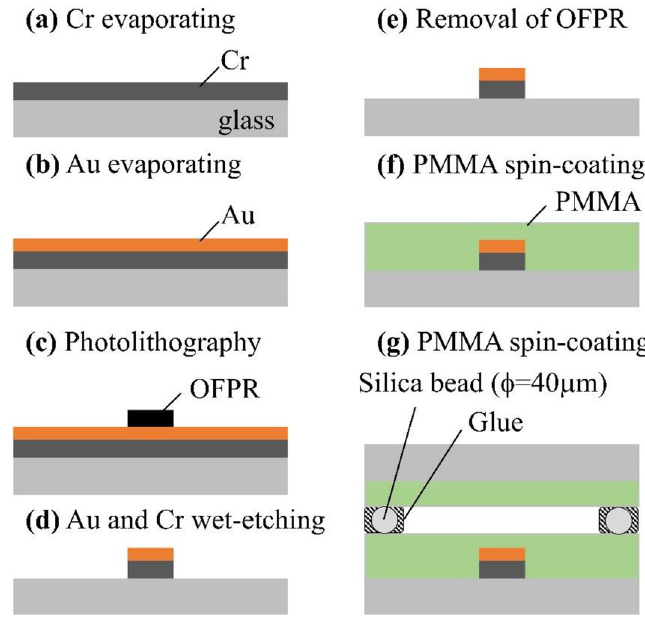
Figure 7. Schematic diagram of the model MEMS device fabrication process. ( a , b ) Thermal evaporation of Cr and Au layers. ( c ) Patterning of OFPR using a photolithography technique. ( d ) Wet-etching of the Au and Cr layers. ( e ) OFPR removal by washing with an organic solvent. ( f ) Spin coating of the PMMA alignment film. ( g ) LC cell assembly with a thickness maintained at 40 µm by bead